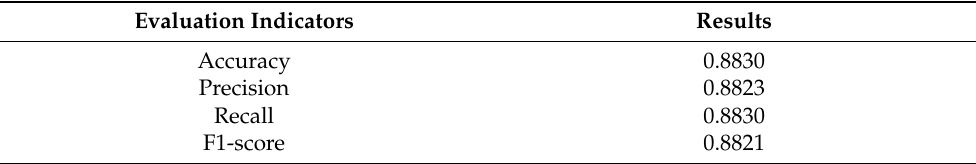
Table 6. Evaluation indicators of test results for music genre classification.